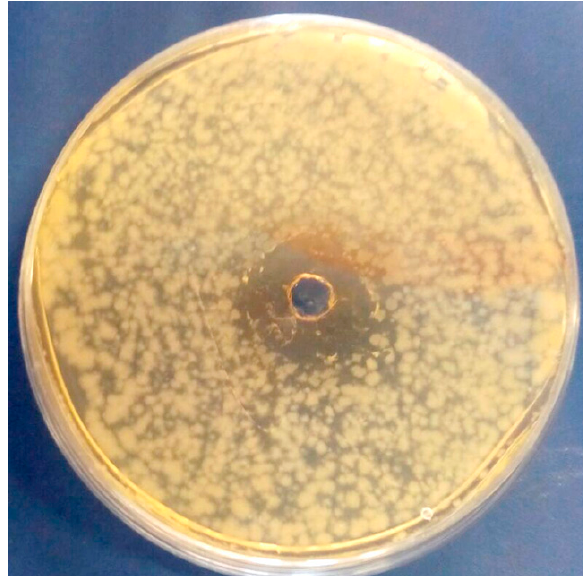
Figure 3. Antibacterial effect of olive leaf extract (OLE) in Petri plates inoculated with Bacillus cereus .